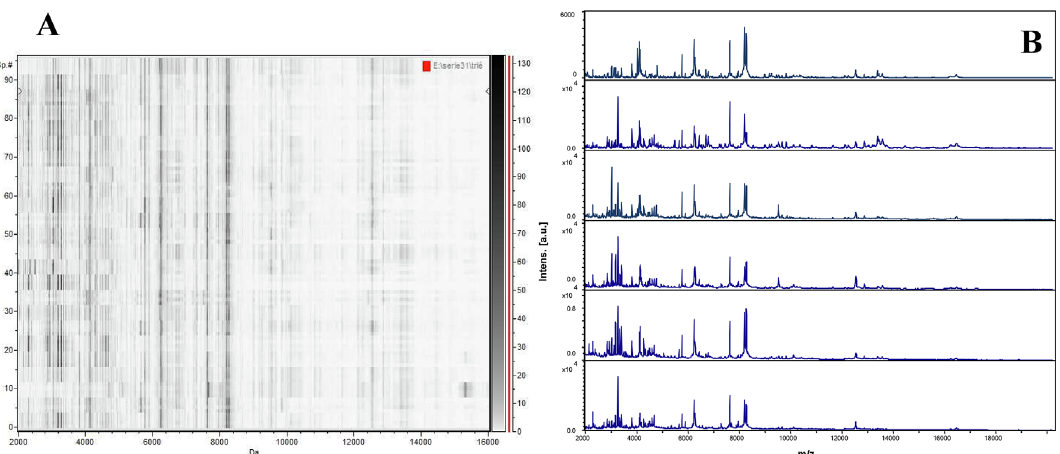
Figure 3. MALDI-TOF analysis of Pediculus humanus corporis . (A) MS pro fi les of 24 specimens using the gel view tool of ClinProTools